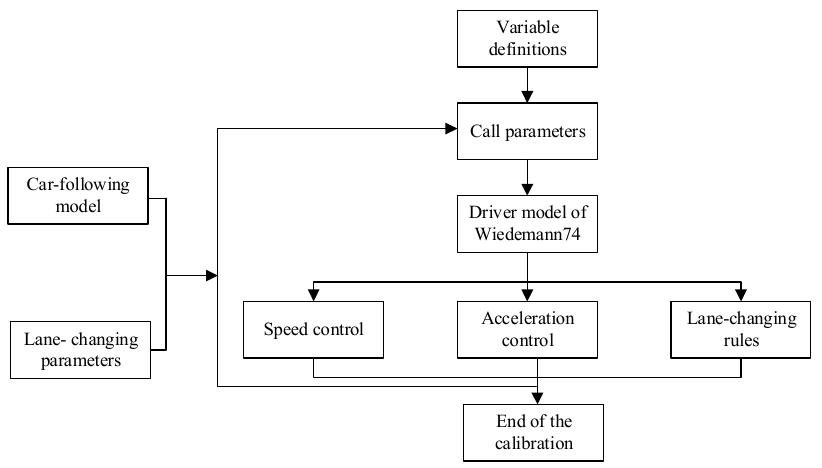
Figure 3. The setting process of driving behavior parameters of cruising vehicles.